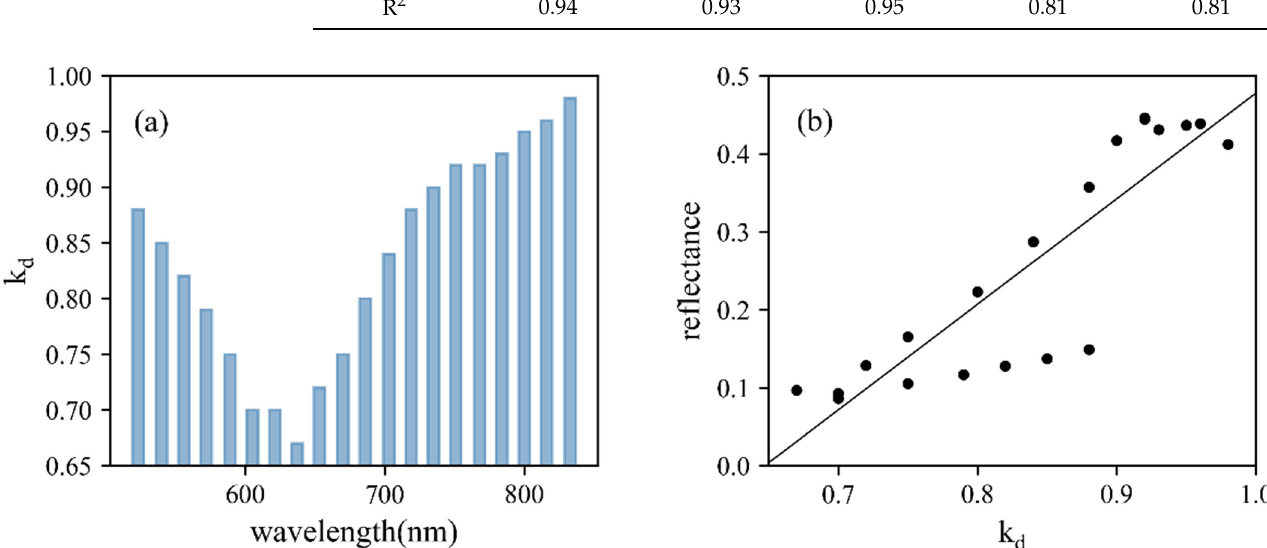
Figure 9. ( a ) The diffuse fraction, k d , of constructed Lambertian–Beckmann models. ( b ) The linear relationship between k d and reflectance of 20 wavelength bands.